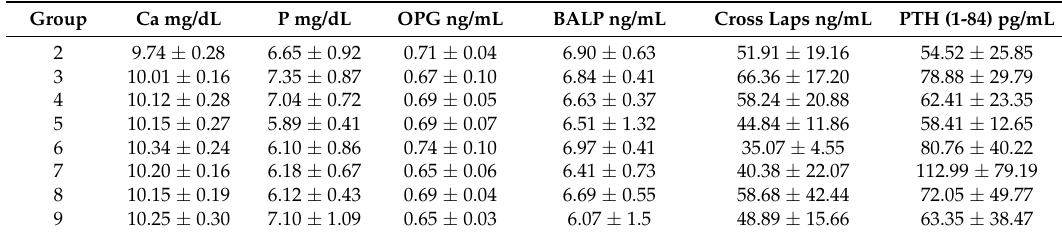
Table 2. Mean values of serum levels at the end of each trial period: Ca, P, OPG, BALP, CrossLaps, PTH and PTH (1-84).